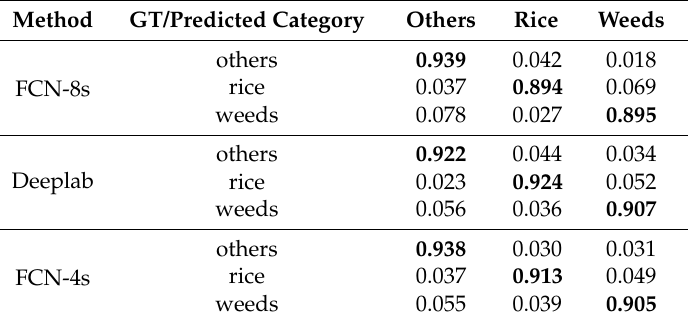
Table 4. Confusion matrix by different semantic labeling approaches. GT—ground